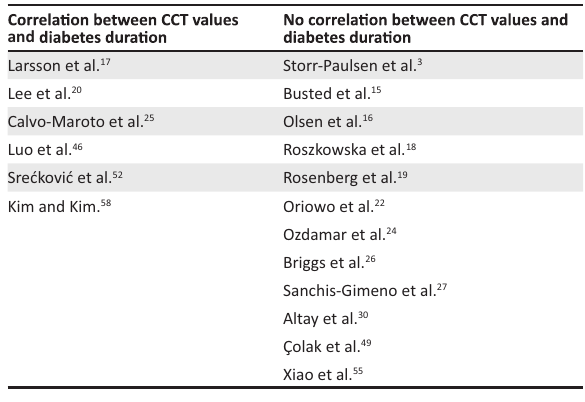
CCT, central corneal thickness. FIGURE 2: A comparative table showing studies that observed positive correlations between central corneal thickness values and diabetes duration versus those that did